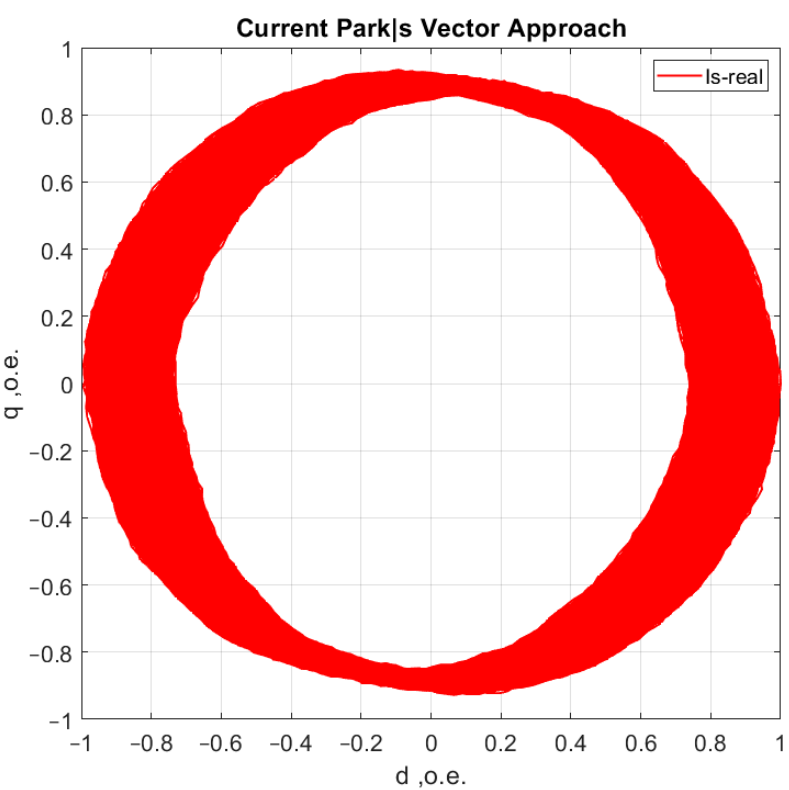
Figure 14. The hodograph at medium defect.